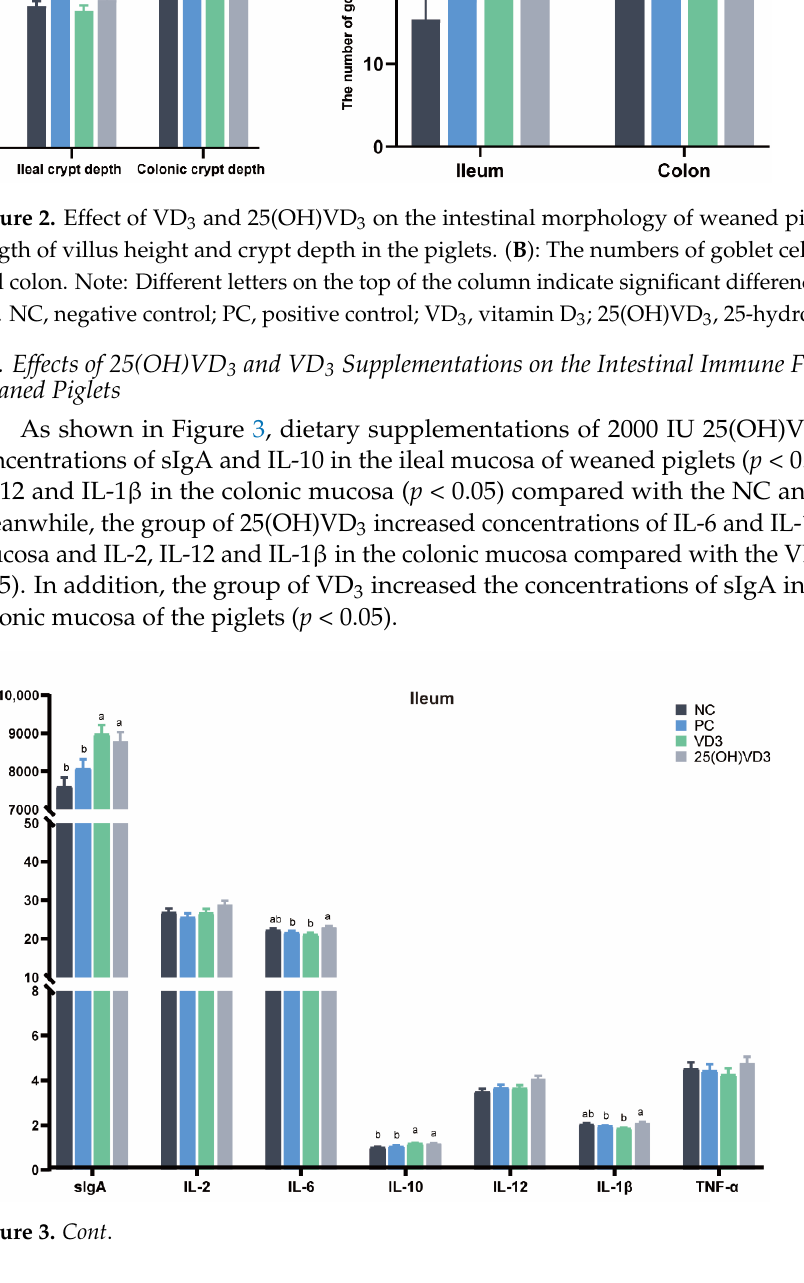
Figure 3. Effect of VD 3 and 25(OH)VD 3 on the intestinal immune function of weaned piglets. ( A ): The concentration of intestinal inflammatory factors in the ileum. ( B ): The concentration of intestinal inflammatory factors in the colon. Note: Different letters on the top of the column indicate signifi- cant differences ( p < 0.05), n = 6. NC, negative control; PC, positive control; VD3, vitamin D 3 ; 25(OH)VD3, 25-hydroxyvitamin D 3 .